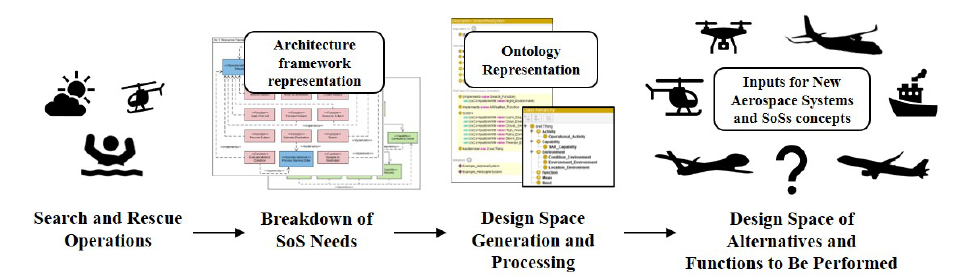
Figure 2. The overall approach and purpose of this